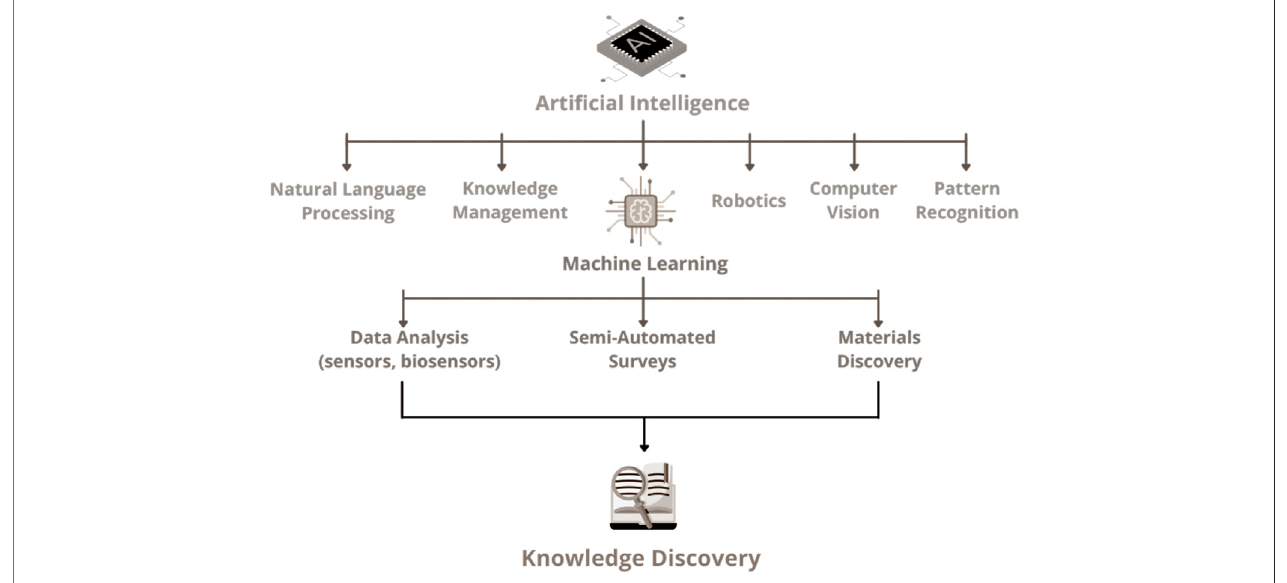
FIGURE 3 | Block diagram illustrating the main AI methodologies, emphasizing the potential applicability of ML in data analysis, materials discovery, and semi- automated surveys. Knowledge discovery is placed as the ultimate AI application, which would be essential for the new paradigm of machine-generated knowledge.